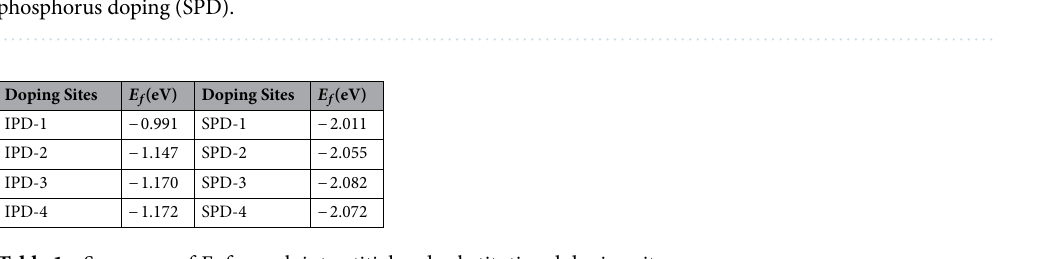
Table 1. Summary of E f for each interstitial and substitutional doping site.